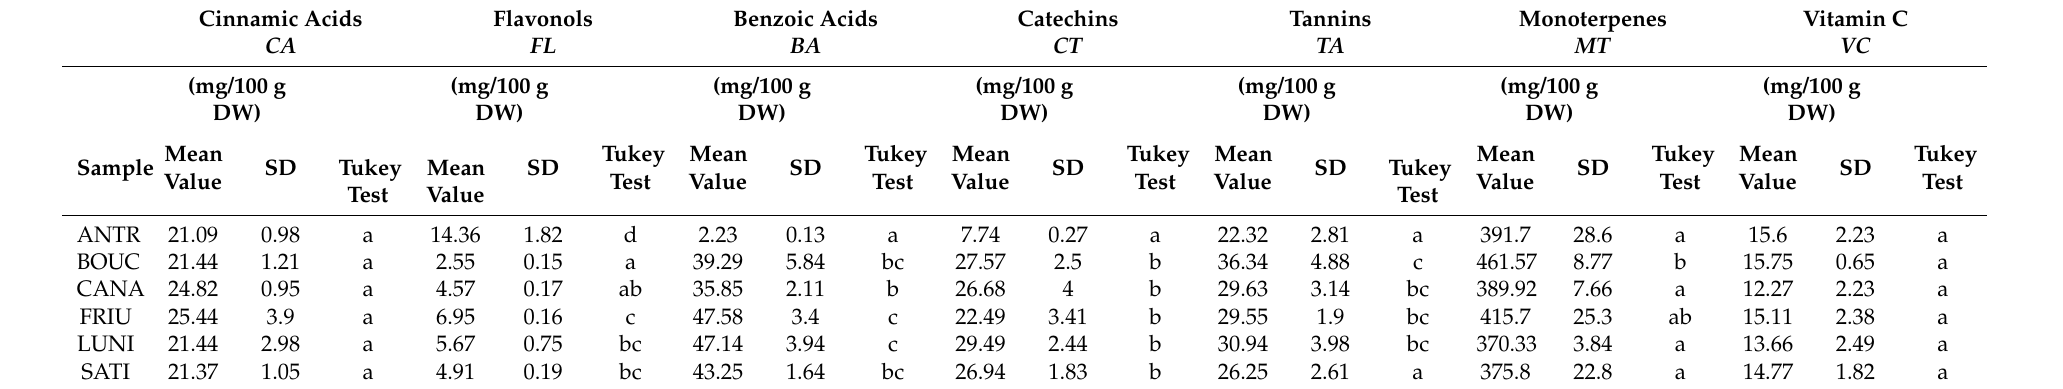
Table 2. Phytochemical profiles of the analysed chestnut